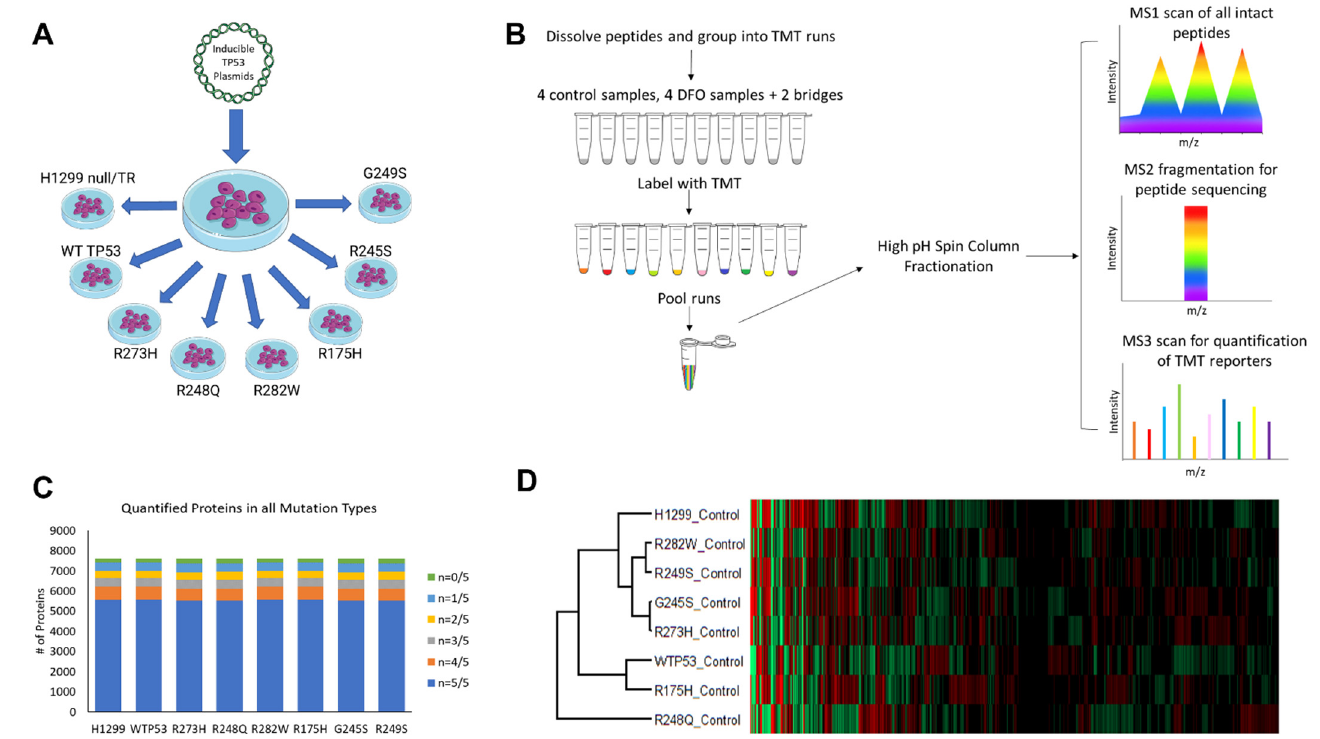
Figure 1. In-depth characterization of the mutant TP53 proteomes. ( A ) Eight isogenic cell lines were generated by transfecting TP53 null H1299 cells with inducible expression plasmids containing either WT TP53 or one of the six indicated TP53 mutation types. ( B ) Cells were treated with ± DFO for 48 h before total protein was collected and lysates were digested with trypsin, labeled with isobaric TMT tags, and pooled, followed by high-pH reversed phase fractionation and analysis by LC-MS/MS. ( C ) Quantified proteome depth including the number of proteins within each biologic rep- licate. ( D ) Hierarchal cluster analysis of distinct TP53 proteomes in untreated cells.